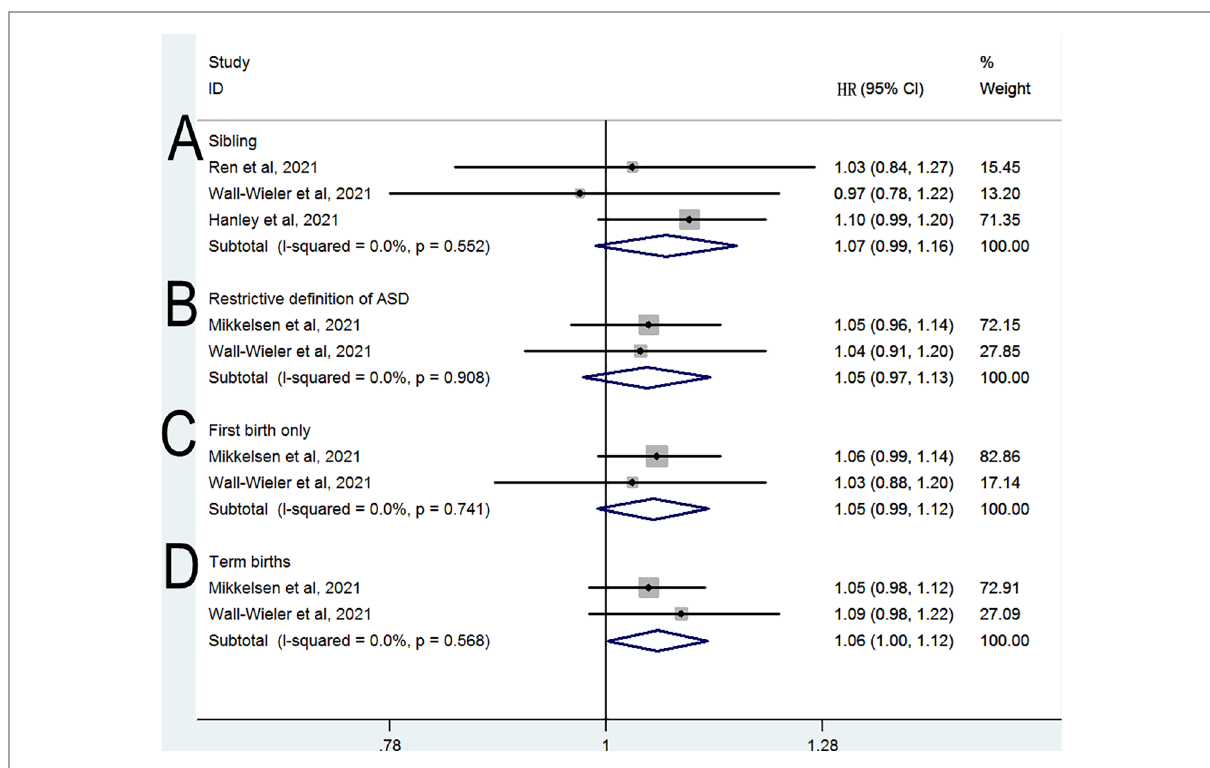
FIGURE 3 Relative risk of subsequent ASD in subgroup analyses ( A ) sibling ( B ) restrictive de fi nition of ASD ( C ) fi rst birth only ( D ) term